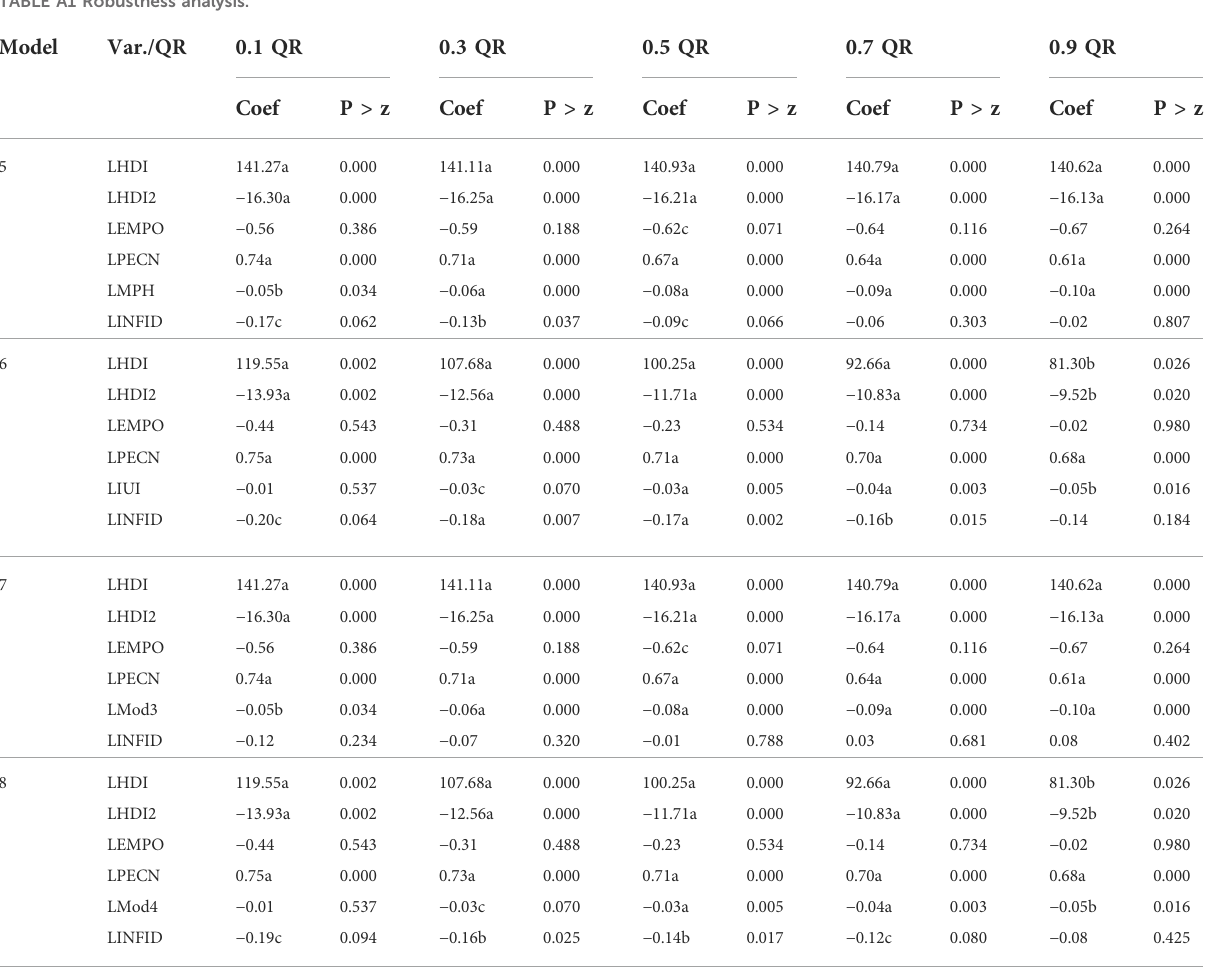
TABLE A1 Robustness analysis.